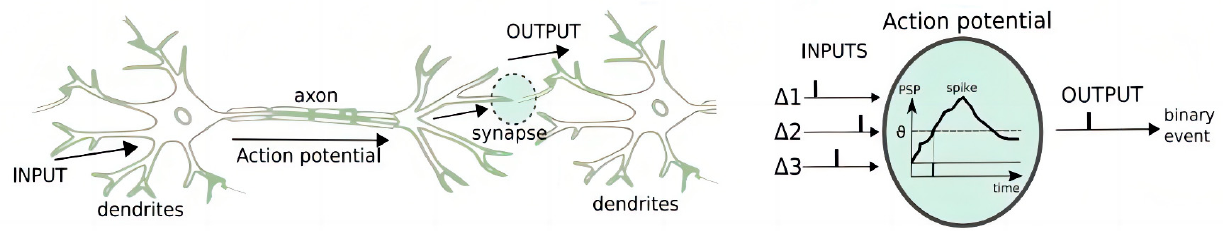
Figure 16. Biological neuron and its association with an artificial spiking neuron. Reprinted with